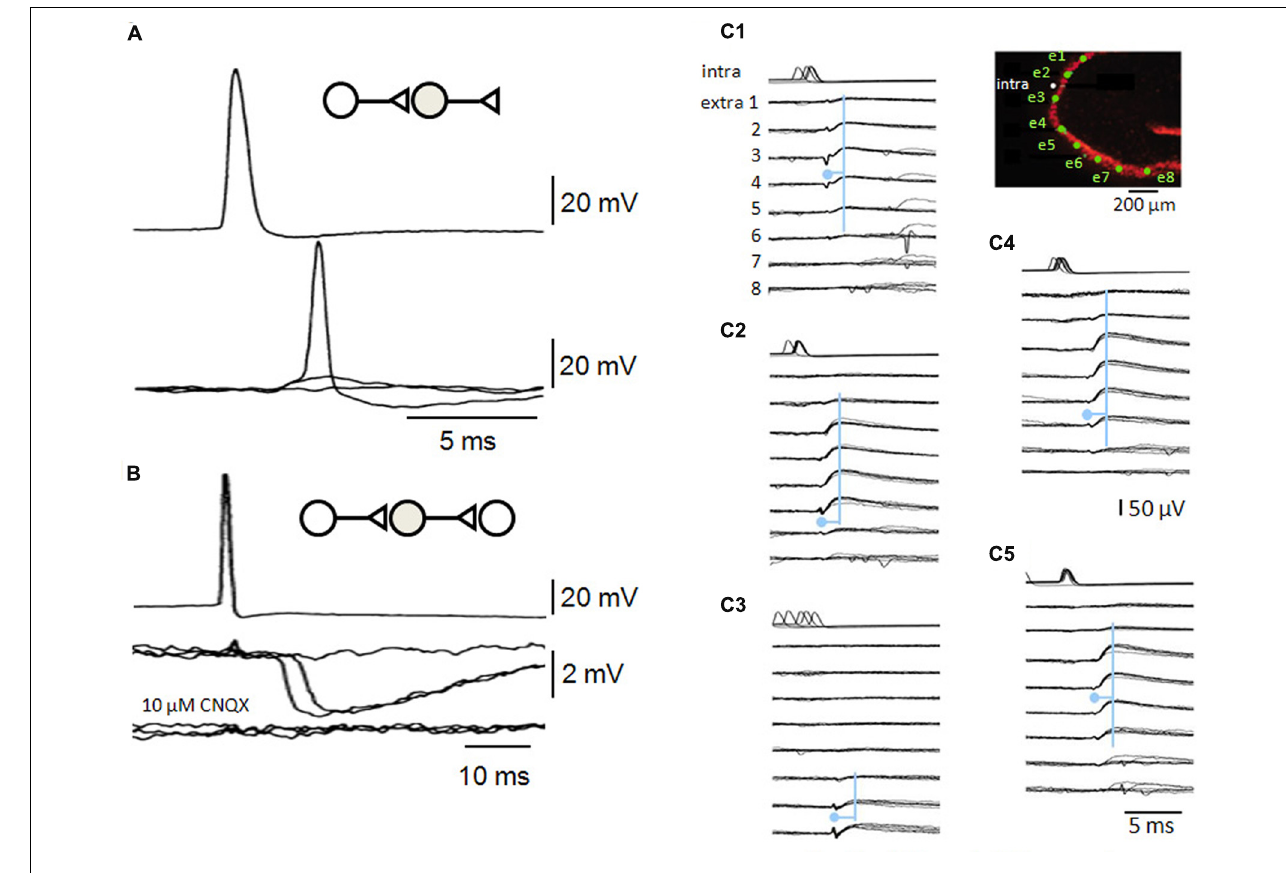
Records from a pyramidal cell (intra) and extracellular records from eight sites in st. pyramidale (extra 1–8, the diagram shows st. pyramidale in red and electrode sites in green). Field IPSPs were detected on electrodes 1–6 (C1) , 2–7 (C2) , 6–8 (C3) , 1–7 (C4) , and 2–6 (C5) repeatably following single action potentials (traces are aligned on six overlapping field IPSPs for each trace). Field IPSPs are preceded by extracellular action potentials of short duration on electrodes 2–3 (C1) , 6 (C2) , 7–8 (C3) , 6–7 (C4) , and 5–6 (C5) .The pyramidal cell may have initiated five distinct di-synaptic inhibitory